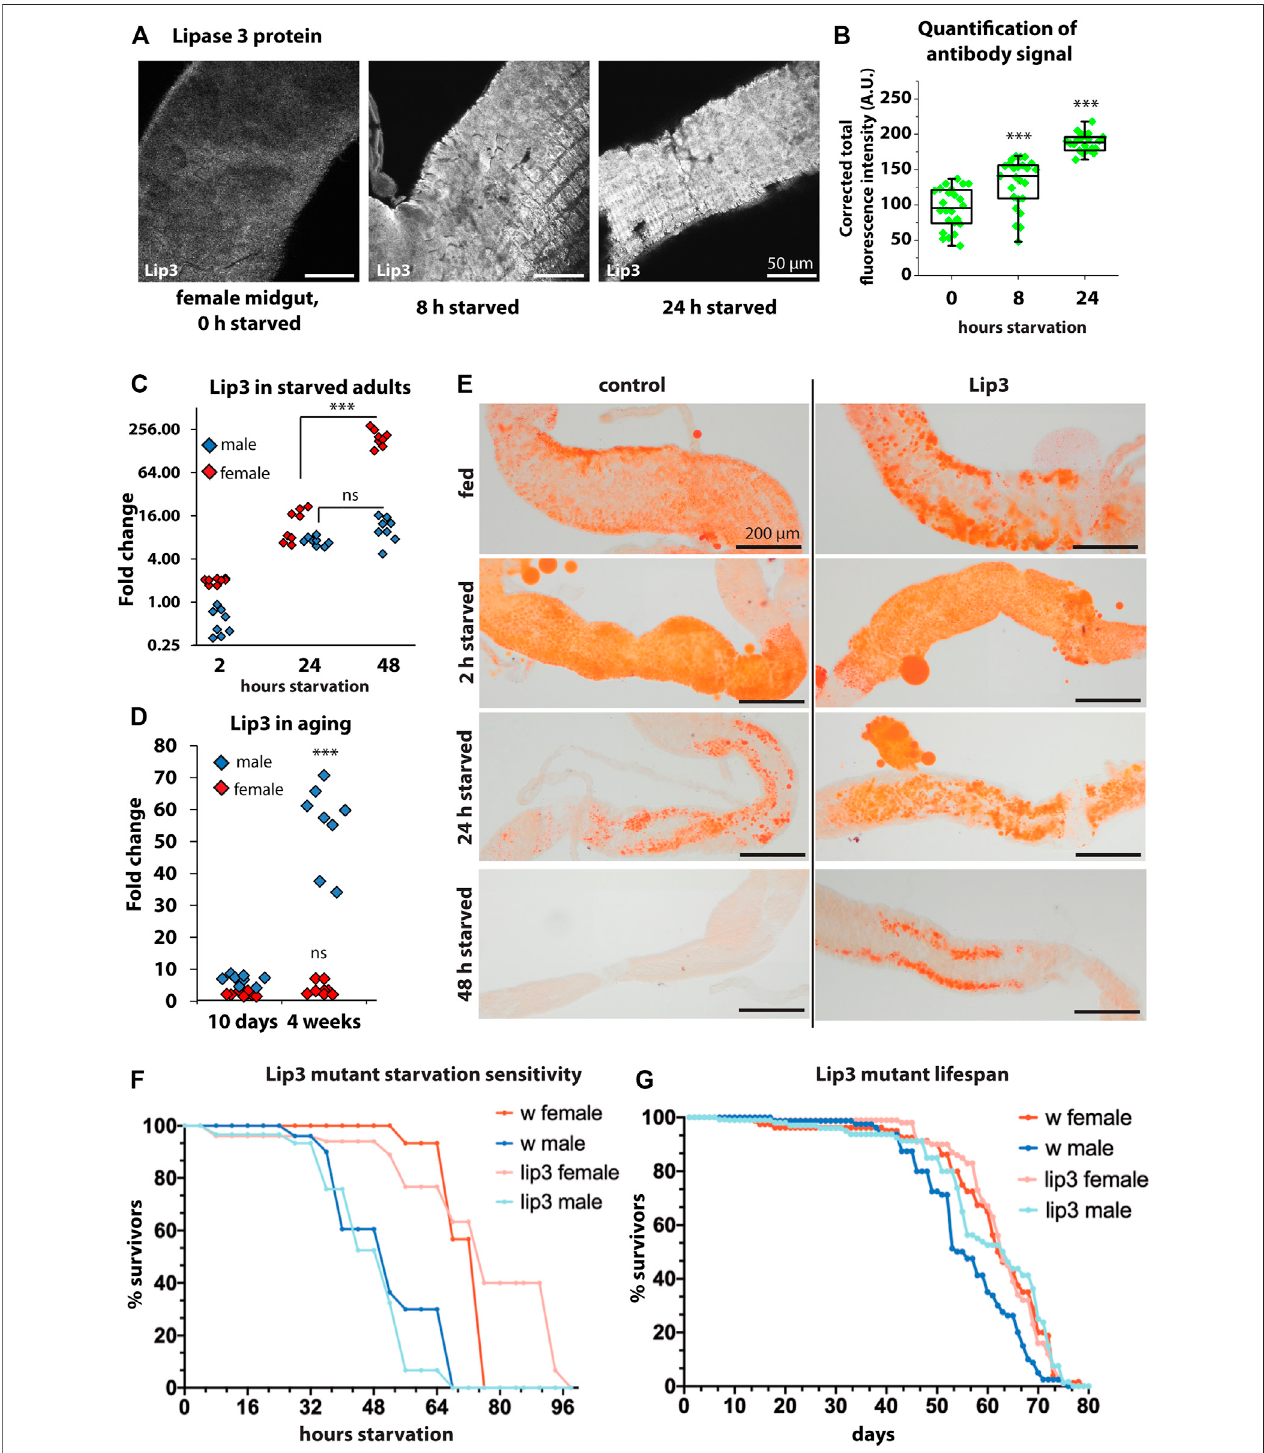
FIGURE 3 | (A) Immuno fl uorescent staining of midguts with anti-Lip3 in fed, 8 h starved, and 24 h starved female fl ies. (B) Quanti fi cation of the fl uorescent signals fromA. (C) Quantitativereal-timePCRofstarvedmaleandfemale fl ies,normalized torp49andactin-5chousekeepinggenesandfedmaleandfemale fl ies,respectively. (D) Quantitative real-time PCR of 10 days (young) and 4 weeks old male and mated female fl ies, normalized to rp49 and actin-5c housekeeping genes and 2 – 5 day old male and female controls, respectively. (E) Oil RedO staining of midguts of female fl ies. (F) Starvation sensitivity assay, curves show average of three biological replicates of groups of 10 fl ies. Mann-Whitney non-parametric tests were applied for statistics but revealed no signi fi cant differences. (G) Longevity assay, curves show average of fi ve biological replicates of groups of 20 fl ies. Mann-Whitney non-parametric test shows that the difference in lifespan between male wildtypes and Lip3 mutants is not quite signi fi cant ( p =